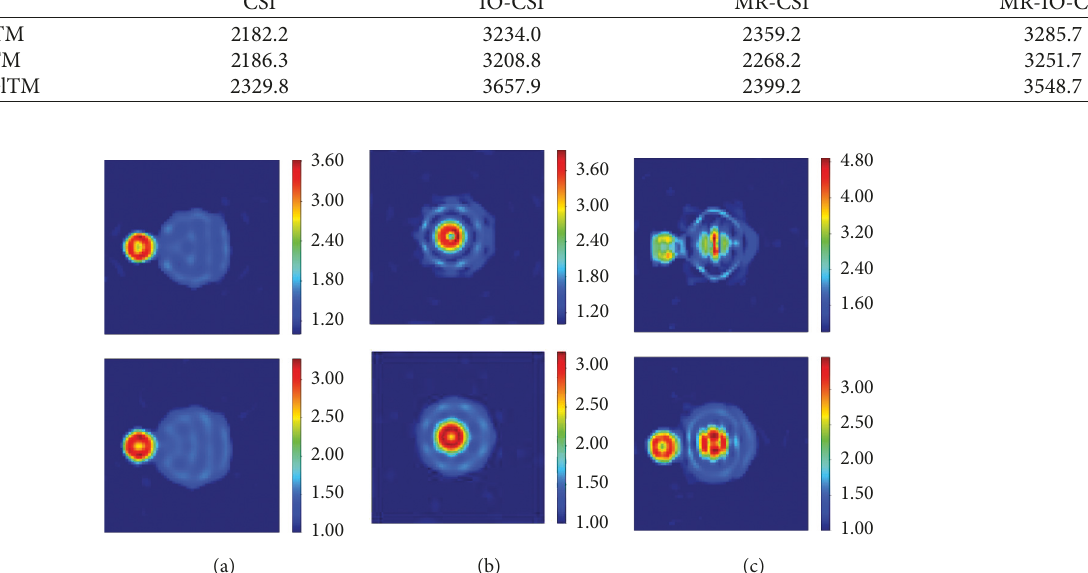
Figure 8: The multifrequency CSI inversion results (first row) and the multifrequency IO-CSI inversion results (second row) of (a) ‘FoamDielExtTM,’ (b) ‘FoamDielIntTM,’ and (c) ‘FoamTwinDielTM’ at 5GHz, 6GHz, 7GHz, and 8GHz.